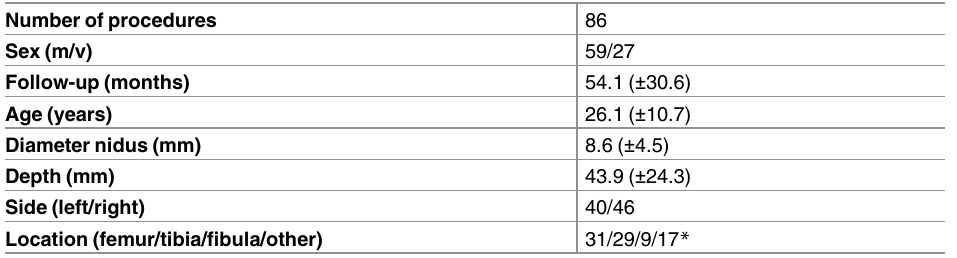
Table 1. Demographics & basic tumour data.